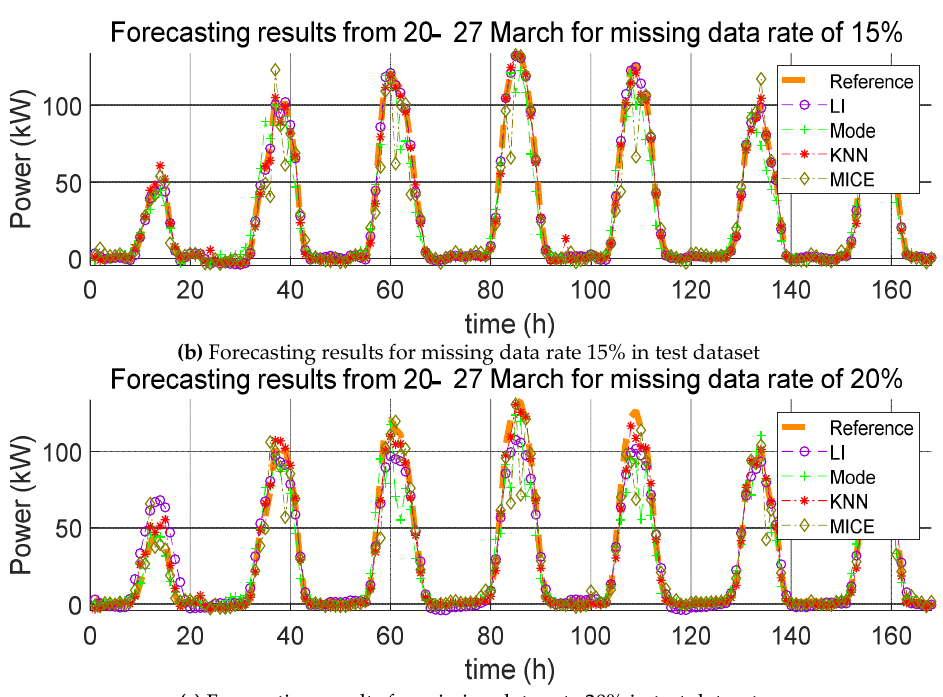
Figure 10. Forecasting results from 20 – 27 March for various missing data rates (10%, 15%, and 20%).